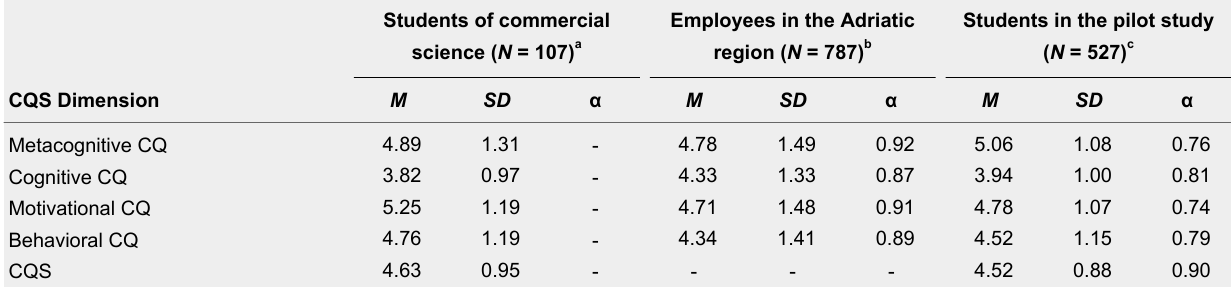
Previous Slovene Studies - Means (M), Standard Deviations (SD), and Internal Consistencies (α) for Dimensions of CQS